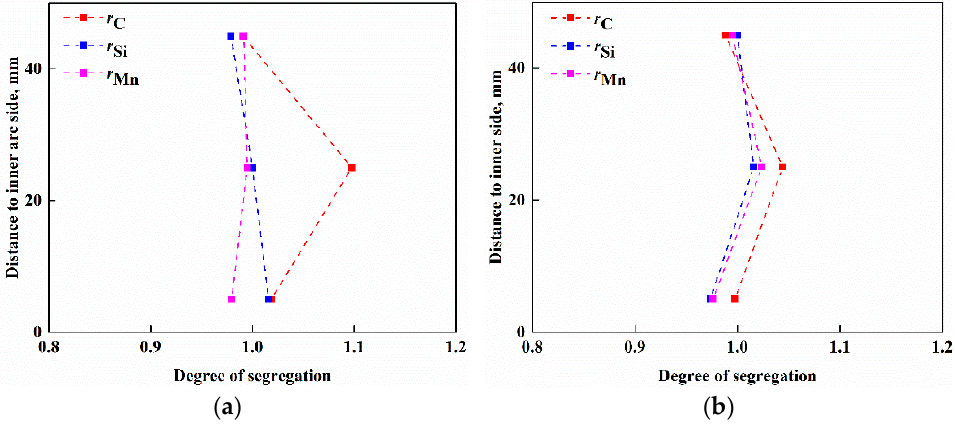
Figure 9. Macro-segregation along thickness direction: ( a ) one-quarter width, ( b ) one-half width. According to literature [38], the macro-segregation depends on (1) partition coefficient ( k ) of solute elements and the parameter, R / k m ( R growth rate and k m mass transfer coefficient), (2) morphology of the solidifying structure, (3) movement of solid and liquid phases during solidification, and (4) the extent of chemical reactions during freezing. In the current study, the (1), (2) and (4) were treated as the same for a certain element in the same position. Considering the bulging of the slab may have an influence on the movement of solid and liquid phases, i.e., factor (3), the thickness along the width direction was measured and is illustrated in Figure 10, where the x-axis represents the distance to the narrow side of the slabs along (as shown in Figure 4) the centerline, and the y-axis reflects the thickness of the slabs measured at intervals of a certain distance along the width direction of the slab.